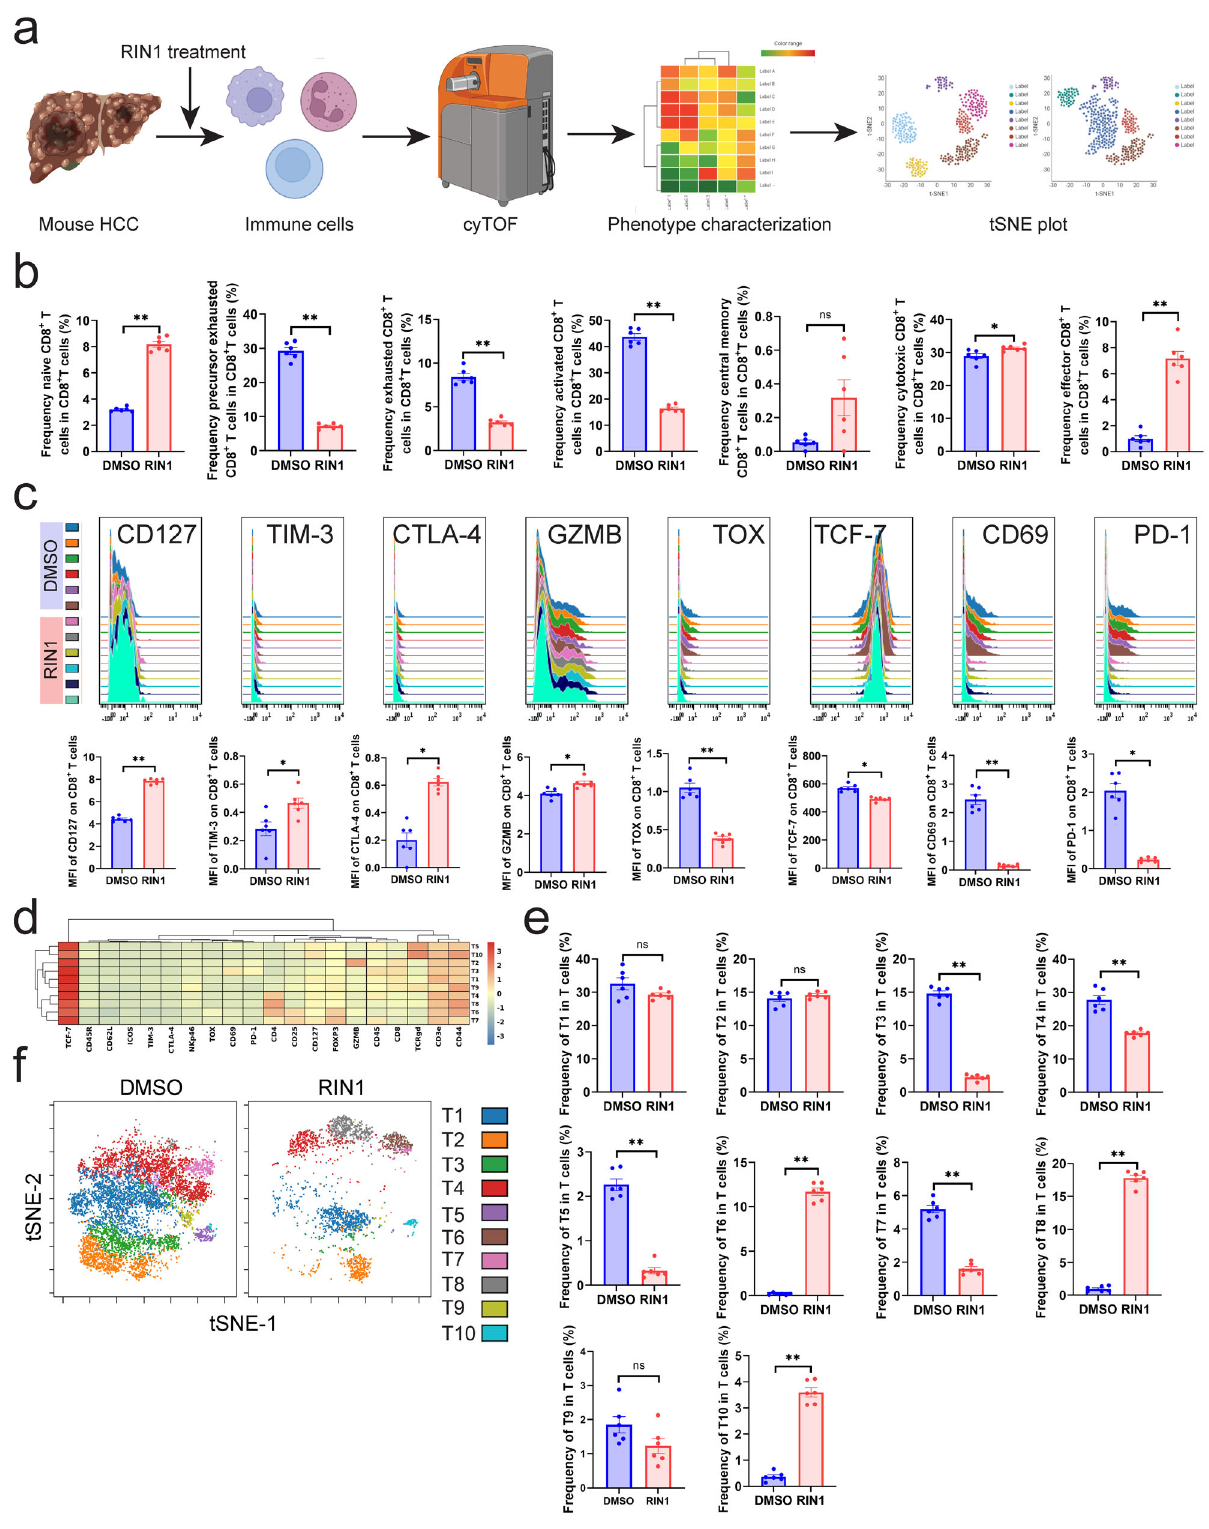
Fig. 3 CyTOF revealed the regulatory effect of RIN1 on in fi ltrating T cells in mouse primary HCC. a Experimental design and analysis work fl ow of cyTOF (all the components were from BioRender (https://biorender.com/)). b Frequency of mouse HCC in fi ltrating CD8 + T cell subpopulations ( n = 6). c Expression of selected functional markers on mouse HCC in fi ltrating CD8 + T cells ( n = 6). d Heatmap of corrected median expression of ten T cell subpopulations ( n = 6). e t-SNE plot of mouse HCC in fi ltrating T cells ( n = 6). f Comparison of the proportions of ten T cell subpopulations ( n = 6). Mean± SD. Statistical signi fi cance determined by paired two-tailed t -test ( b , c , e ). * P < 0.05; ** P <